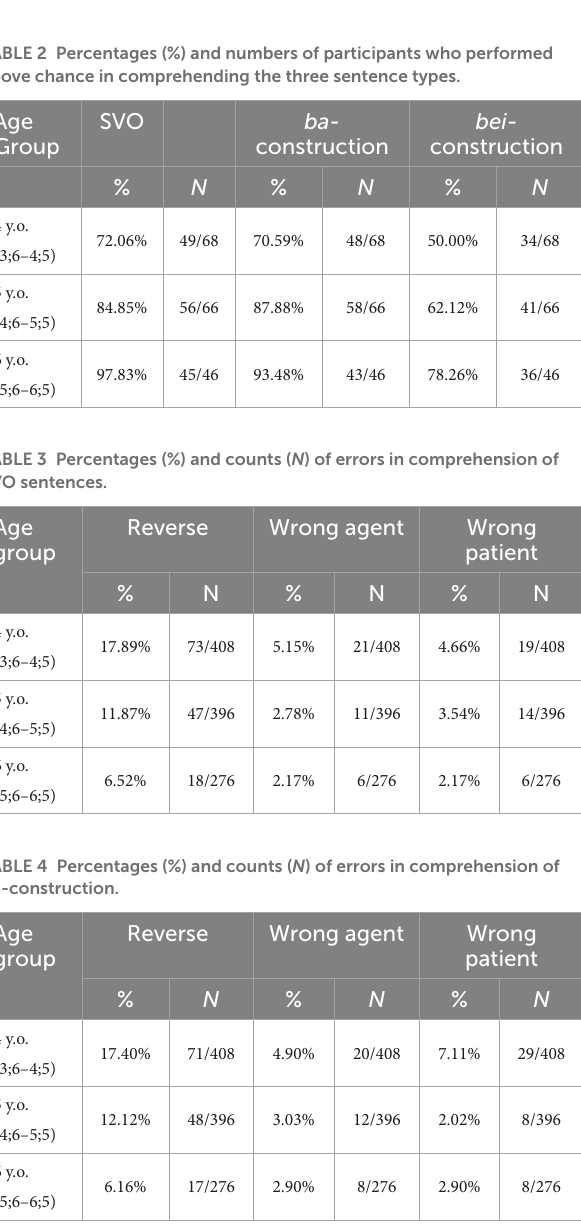
TABLE 5 Percentages (%) and counts ( N ) of errors in comprehension of bei-construction. Age